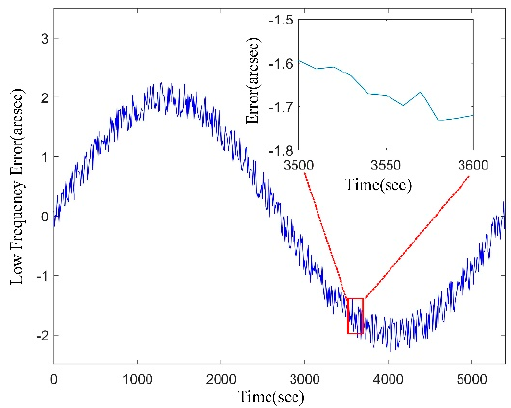
Figure 4. Attitude low-frequency drift errors of the on-orbit satellite.